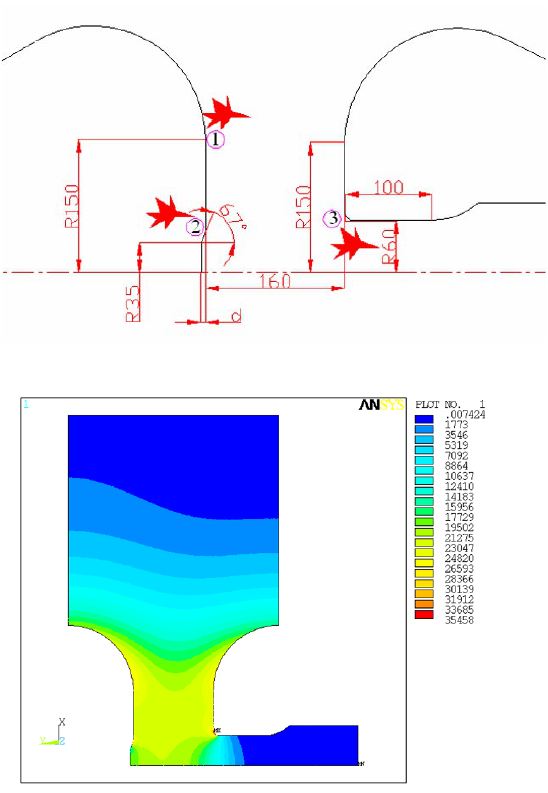
FIG. 5. (Color) Drawing of the configuration (top) and electric field map (bottom) of the diode.